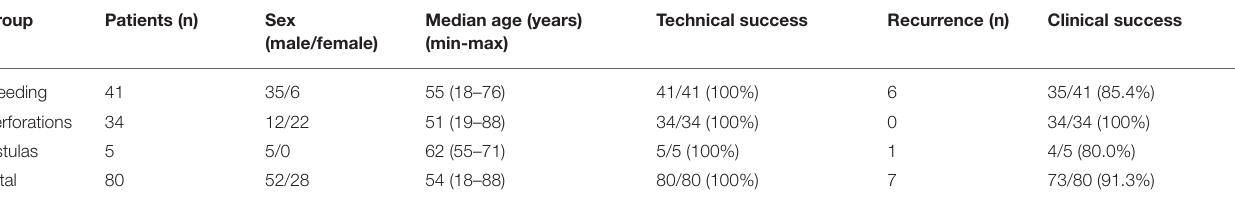
TABLE 1 | Overview on the characteristics and success rates of patients with different indications. Group